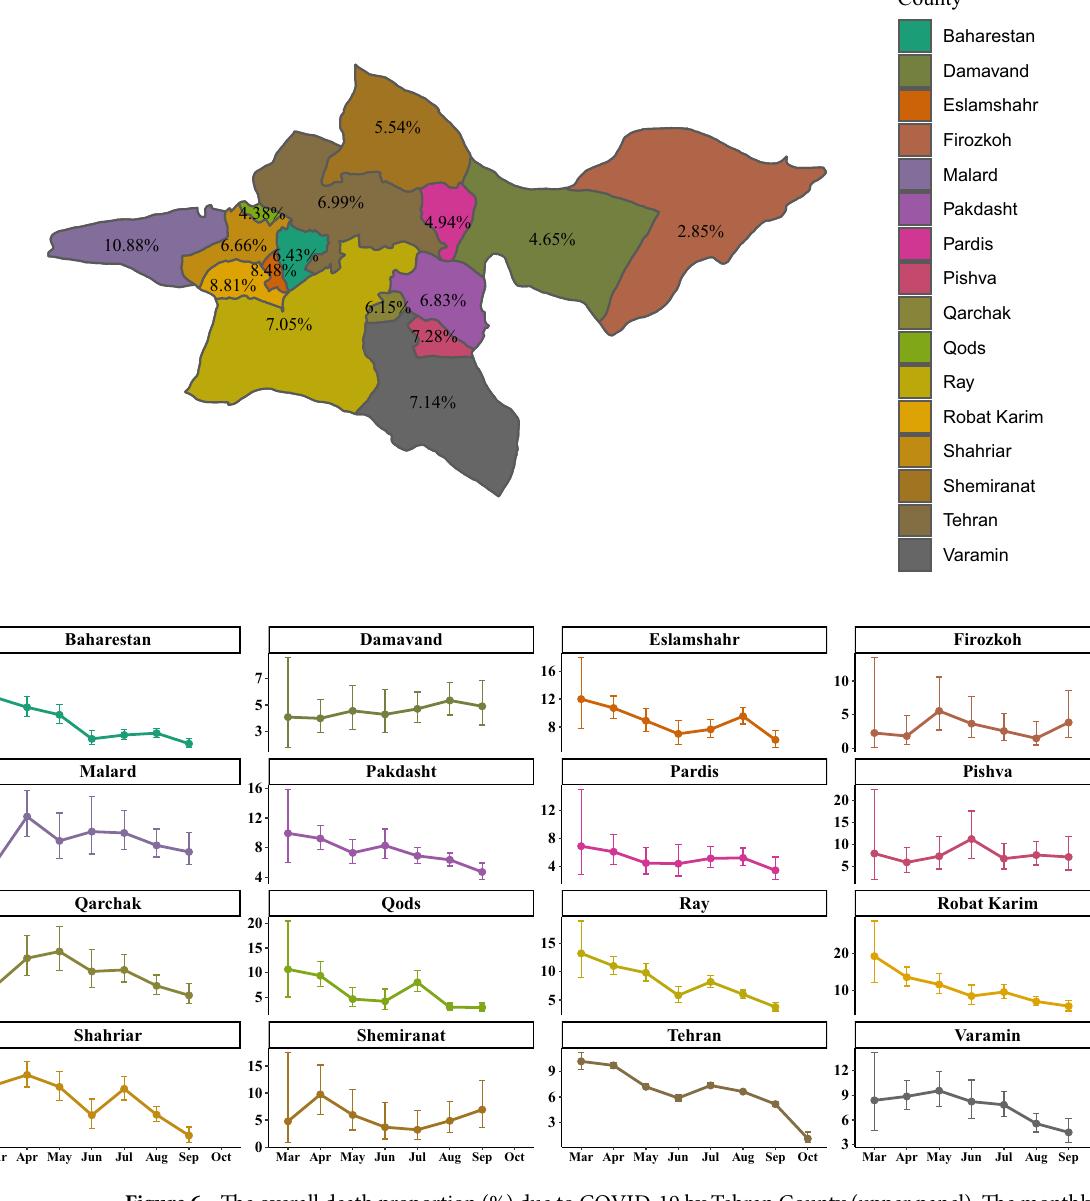
Figure 6. The overall death proportion (%) due to COVID-19 by Tehran County (upper panel). The monthly death proportion due to COVID-19 with 95% confidence interval by Tehran County (lower